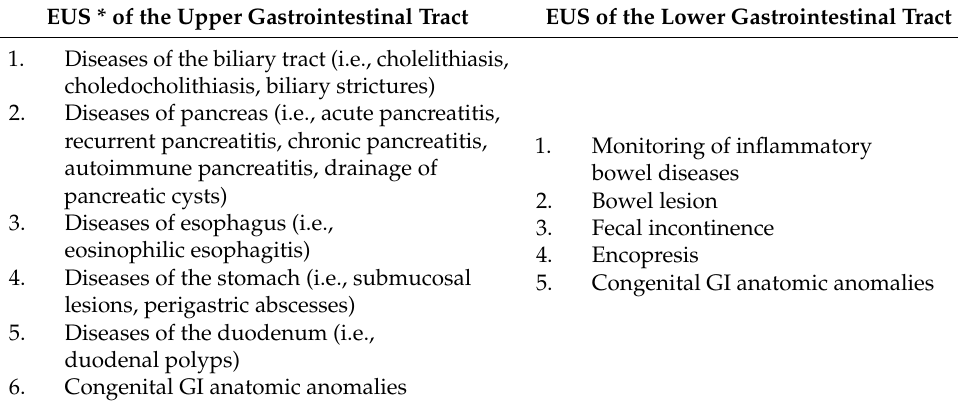
Table 1. Indications for endoscopic ultrasonography in pediatric patients